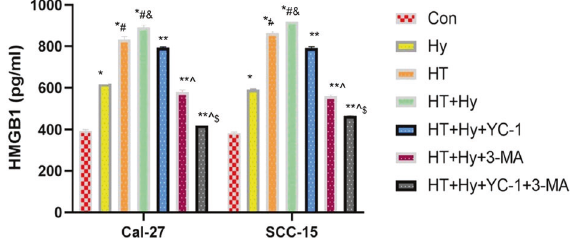
Fig. 6 HT combined YC-1, 3-MA alone or both inhibited the secretion of HMGB1 in Cal-27 and SCC-15 cells under hypoxia and starvation microenvironment as measured by ELISA. Data were presented as mean ± SEM from three independent experiments. Con control, HT hyperthermia, Hy hypoxia, YC-1: 3-(5 ′ -hydroxymethyl-2 ′ - furyl)-1-benzylindazole; 3-MA:3-methyladenine; * p < 0.05 vs. Con group; # p < 0.05 vs. HT group; & p < 0.05 vs. Hy group; ** p < 0.05 vs. HT + Hy group; ^ p < 0.05 vs. HT + Hy + 3-MA group; $ p < 0.05 vs. HT + Hy + YC-1 group; ns no signi fi cant difference ( p >